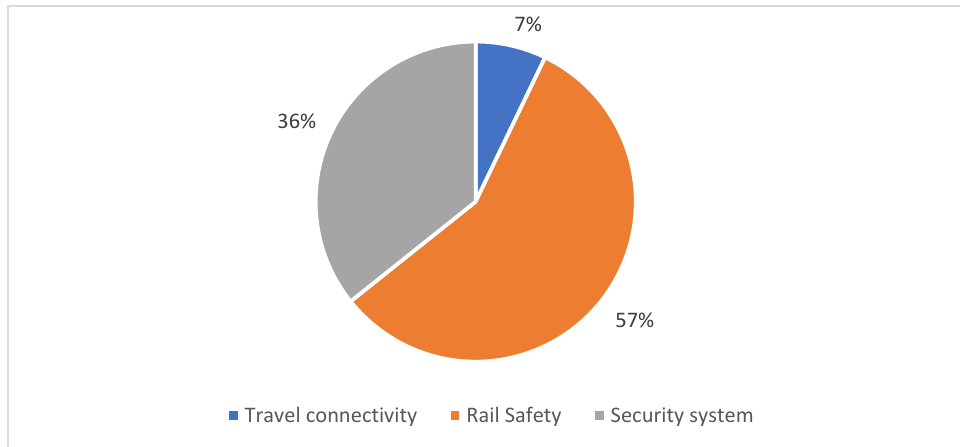
Figure 6. Distribution of the selected papers by communication and security domain.